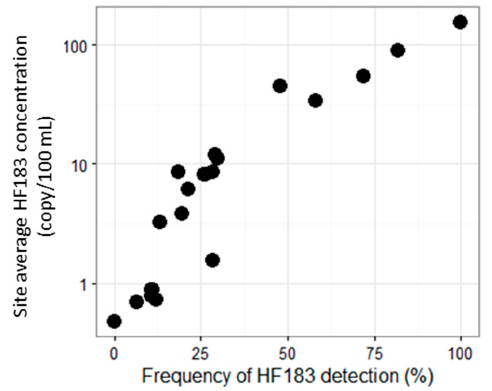
Figure 3. Site average HF183 concentration versus frequency of HF183 detection in summer dry conditions. Frequency of HF183 detection is defined as % samples that are positive for HF183, and a sample is considered positive for HF183 if the marker is amplified in any of the three qPCR replicates. The site average concentration is calculated as the geomean of sample concentrations with non-detected (ND) and DBLOD values substituted by the Poisson approach, as described in Appendix A.